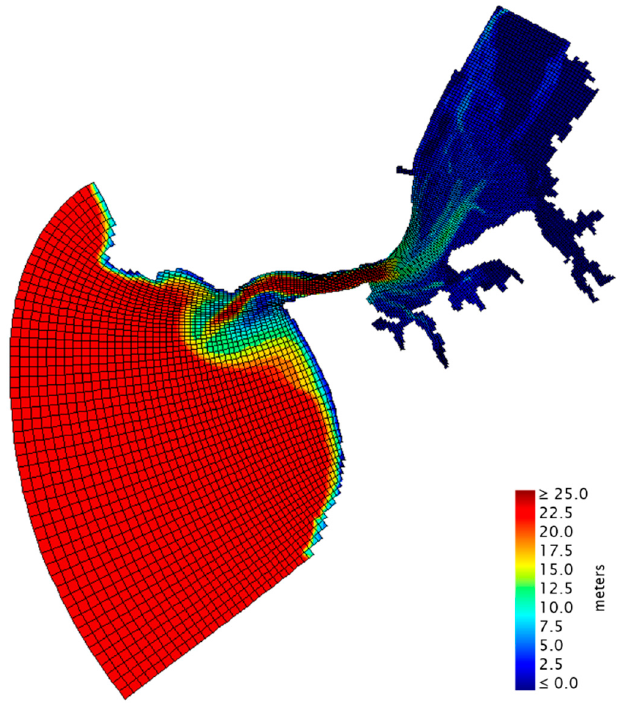
Figure 2. Numerical grid and bathymetry of the study area. Table 1. Parameters and specifications of model implementation.